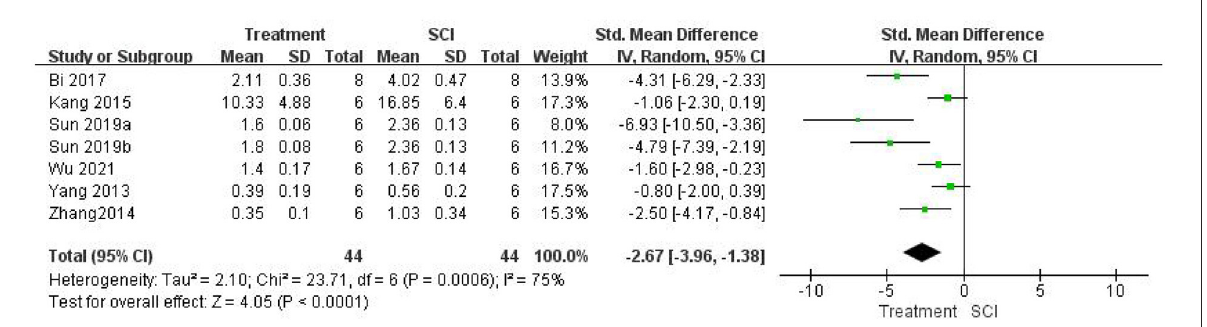
FIGURE4 Forest plot for the effects of HMGB1 intervention on HMGB1 expression in SCI (random-effects model).